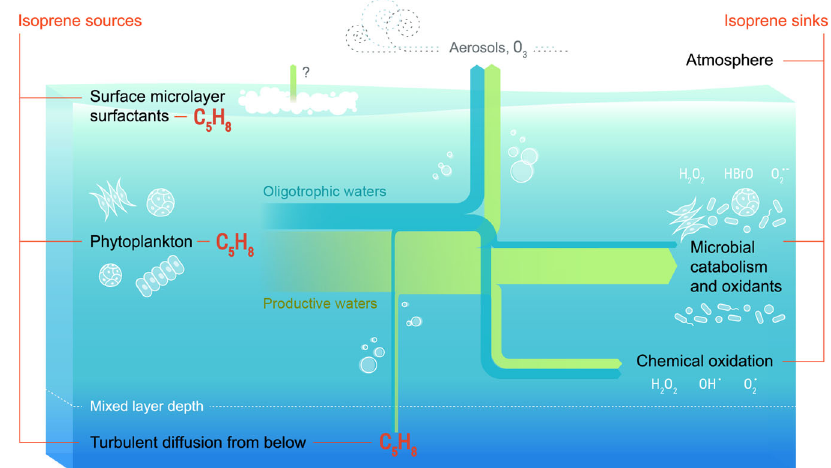
Fig. 4 Relative magnitude of isoprene cycling processes in the surface ocean, according to oceanic productivity. The width of the arrows is proportional to the magnitude of the process rate constants (d − 1 ), which have been averaged from the seven oligotrophic sites with [chl a ] <0.4 mg m − 3 (blue arrows) and from the four productive sites with [chl a ] >0.4 mg m − 3 (green arrows). Note the change in the relative magnitude of the sinks. The question mark next to the isoprene emission from photochemical reactions onto sea surface surfactants indicates the uncertainty in the magnitude of this source in productive